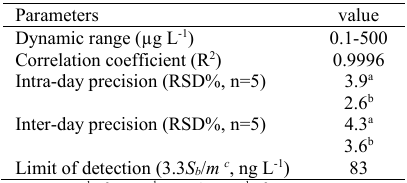
Table 2 The characteristic data of the proposed method. Table 2. The characteristic data of the proposed